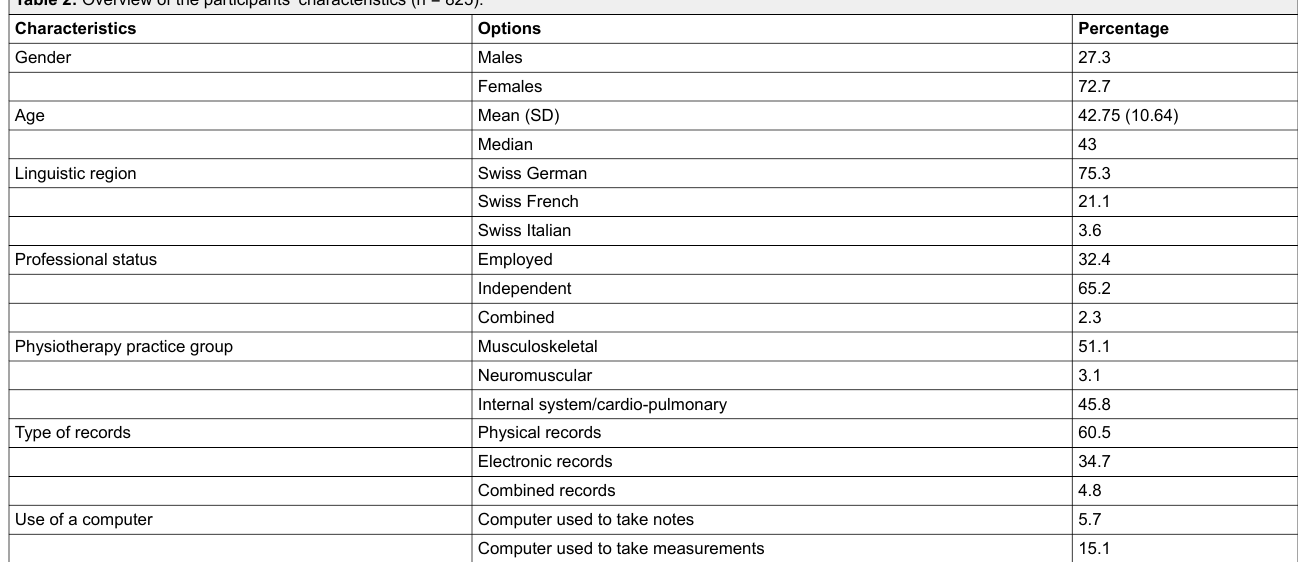
Table 2: Overview of the participants’ characteristics (n = 825).